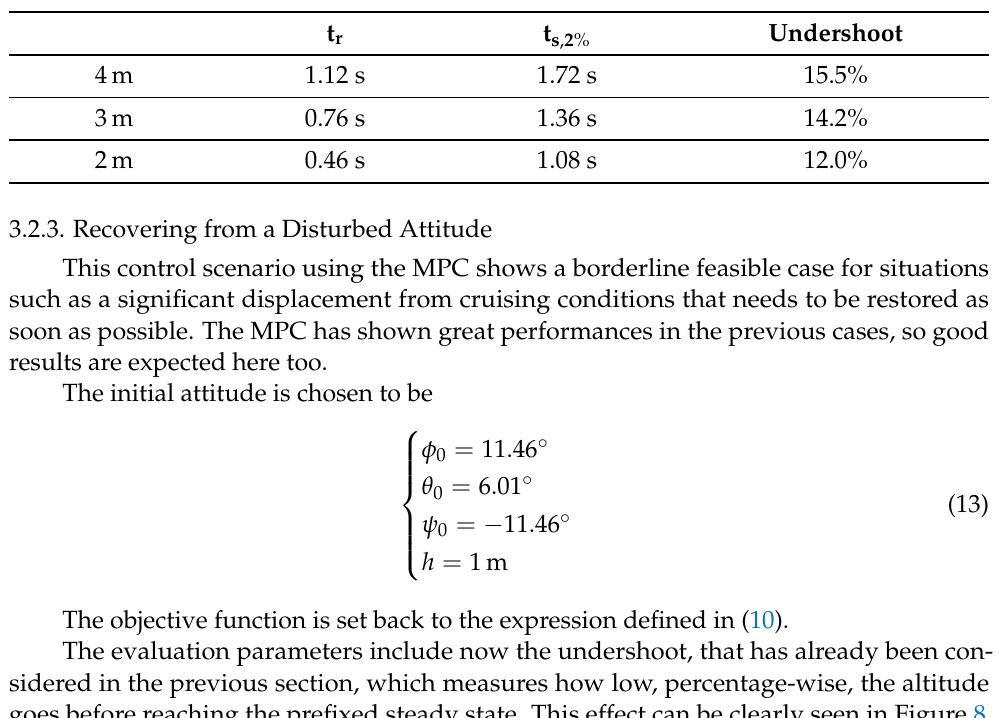
Table 6. Height overshoot for different altitudes for the MPC with constraints on control surfaces,